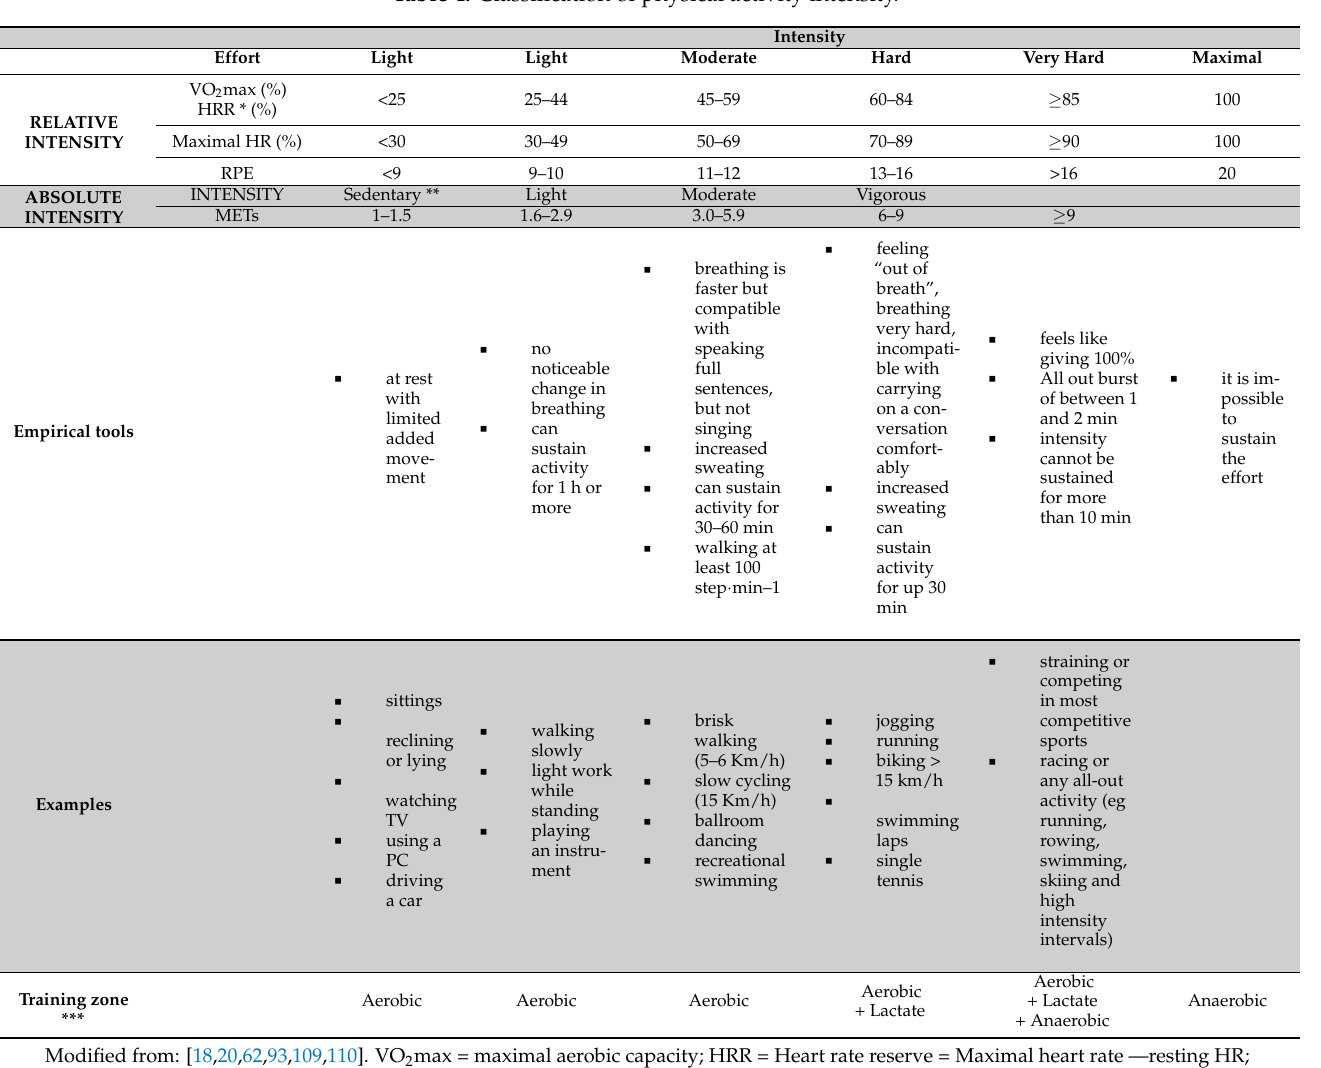
Table 4. Classification of physical activity intensity.